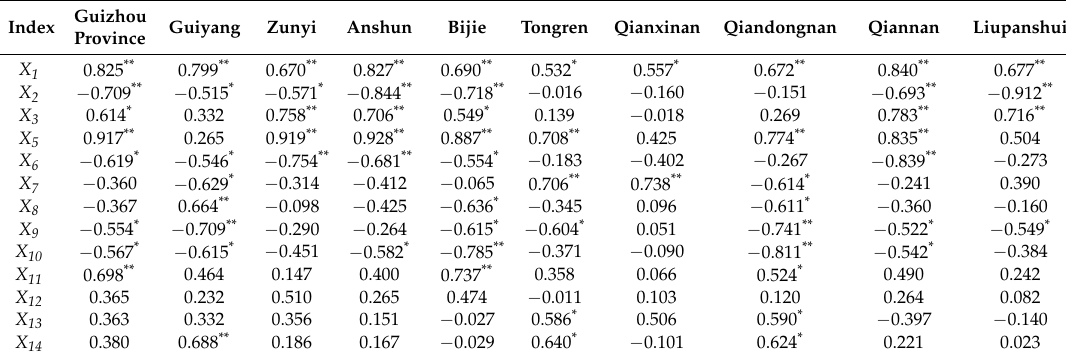
Table 3. Pearson correlation coefficient between the WRSCI and change indicators in various cities and states in Guizhou Province.